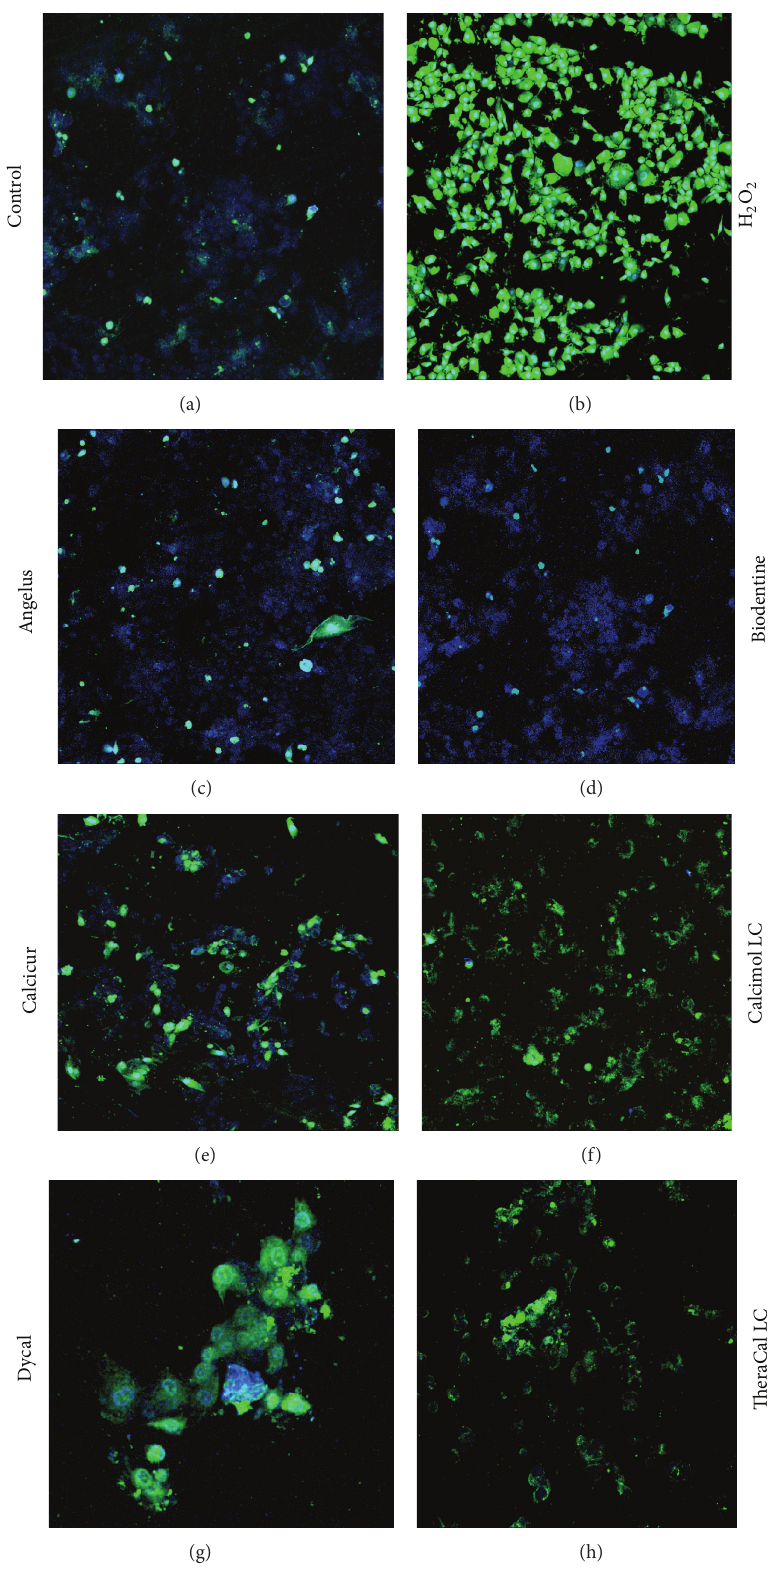
Figure 3: CLSM images of apoptosis assay. MDPC-23 cells were cultured in a 24-Transwell-tissue culture plate for 24 h at 37 ∘ C in the absence of any material (a) or in the presence of H 2 O 2 (b), MTA Angelus (c), Biodentine (d), Calcicur (e), Calcimol LC (f), Dycal (g), and TheraCal LC (h). PSVue480 reagent was used for staining apoptotic cells. CLSM images were taken at 20x